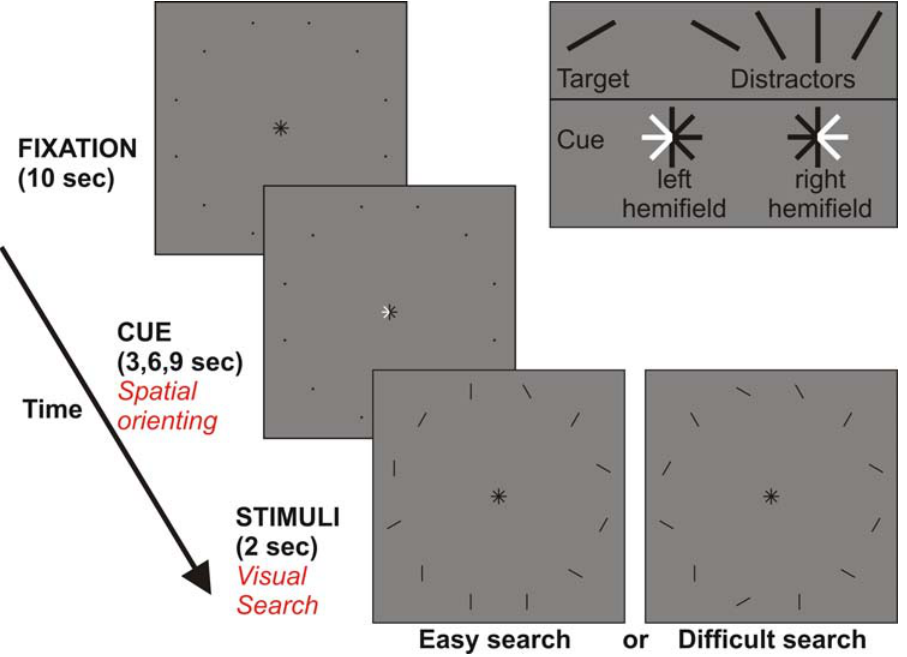
Figure 1. Paradigm separating spatial orienting (SO) and visual search (VS). After a fixation period, a central cue indicated the relevant hemifield for the next trial. When stimuli appeared, subjects had to search covertly for a target line among the 6 positions of the cued hemifield. Task difficulty was modified by the number of distractors with nonvertical orientations in the relevant hemifield (easy: 2; difficult: 5).